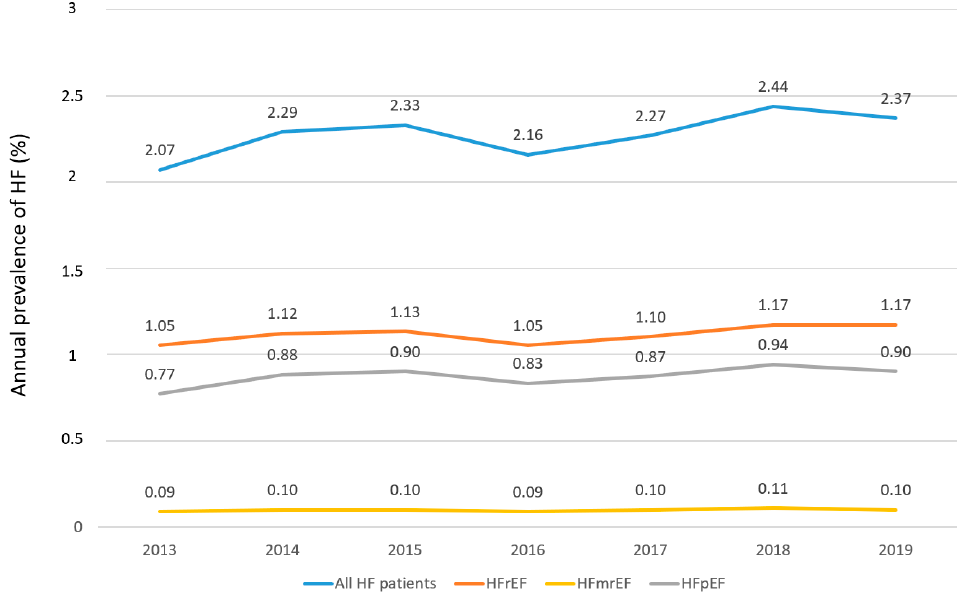
Figure 2. Annual prevalence of HF. Abbreviations: HF = Heart failure; HFmrEF = Heart failure with mildly reduced ejection fraction; HFpEF = Heart Failure with preserved ejection fraction; HFrEF = Heart failure with reduced ejection fraction; HFuEF = Heart Failure with un-specified ejection fraction. Data were recorded until September